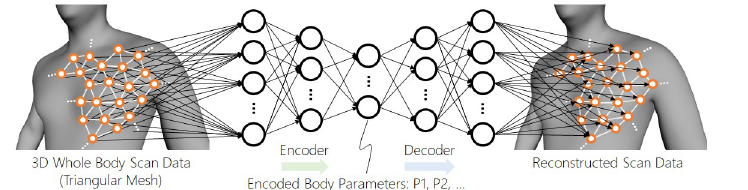
Fig 4. Schematic illustration of the proposed graph autoencoder. A discrete-sampled scalar field acts as input and output nodes of the autoencoder. The intermediate layers are similar to the ordinary autoencoder